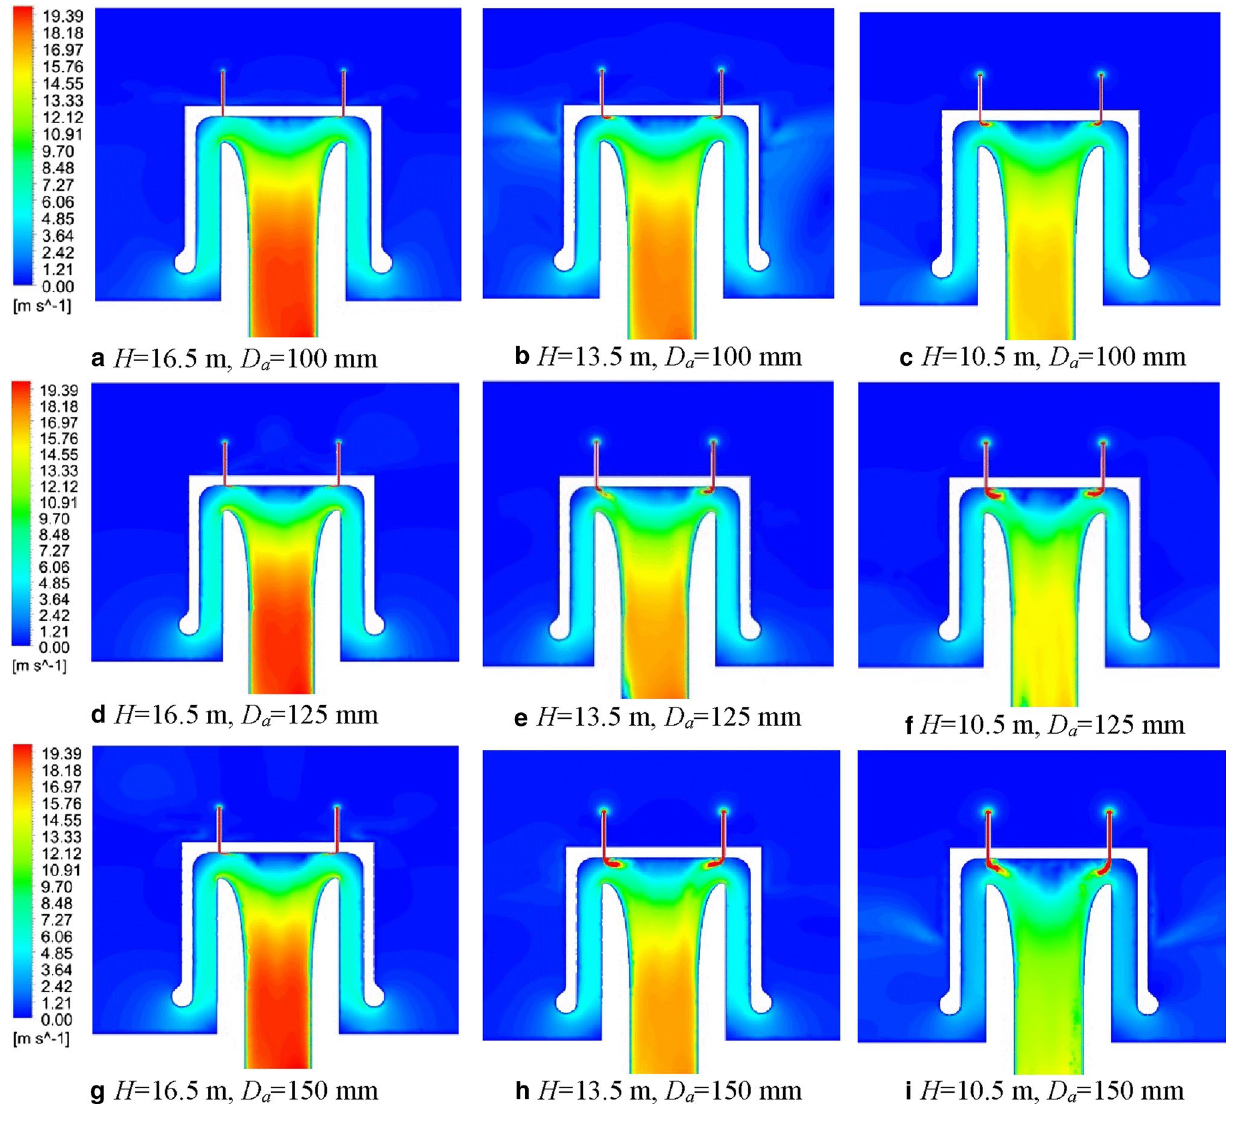
Fig. 6 Velocity contours of the siphon flow for different aeration diameters and operating